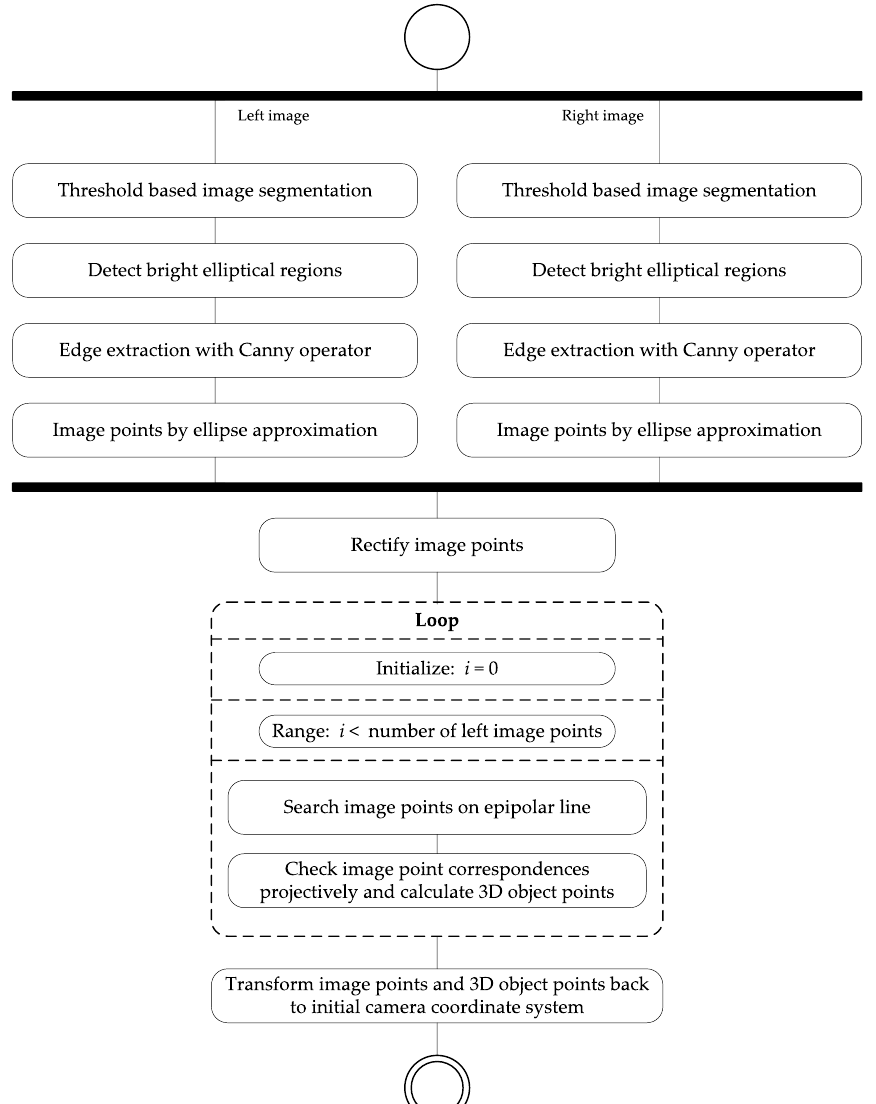
Figure 1. Activity diagram of the image processing for segmentation of the object points in the images and correspondence analysis among the segmented image points in the stereo image